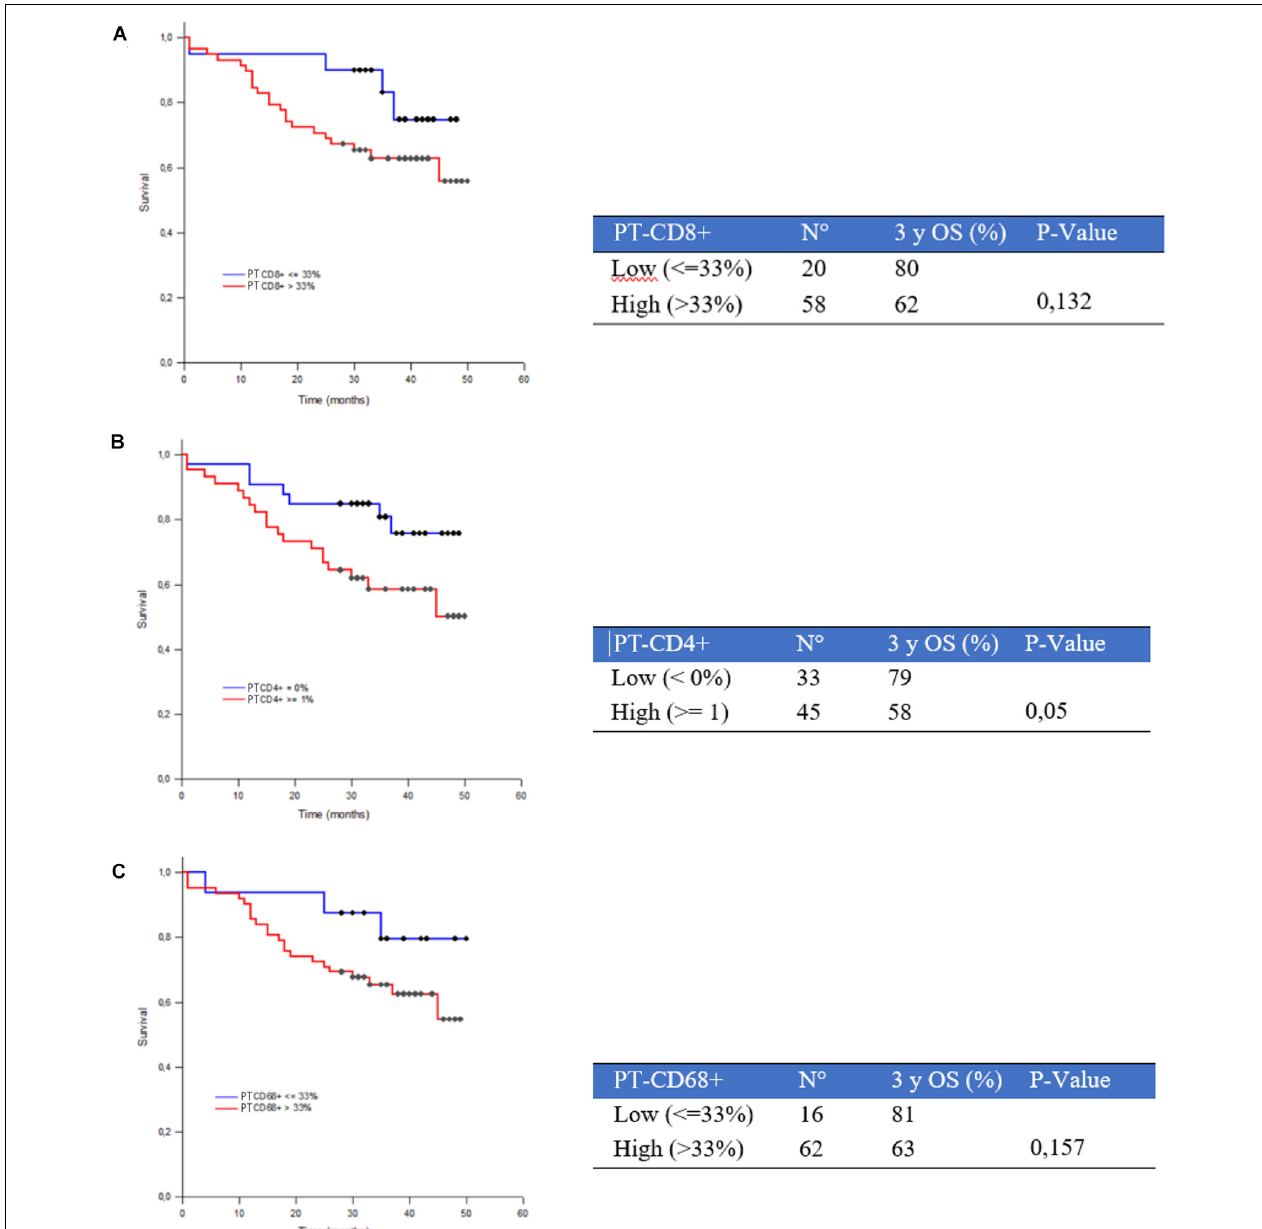
FIGURE 4 | Three-year survival rate (3yOS) data and curves according to low and high peritumoral density of CD8+ T-lymphocytes (A) , CD4+ T-lymphocytes (B) , and CD68+ macrophages (C) .